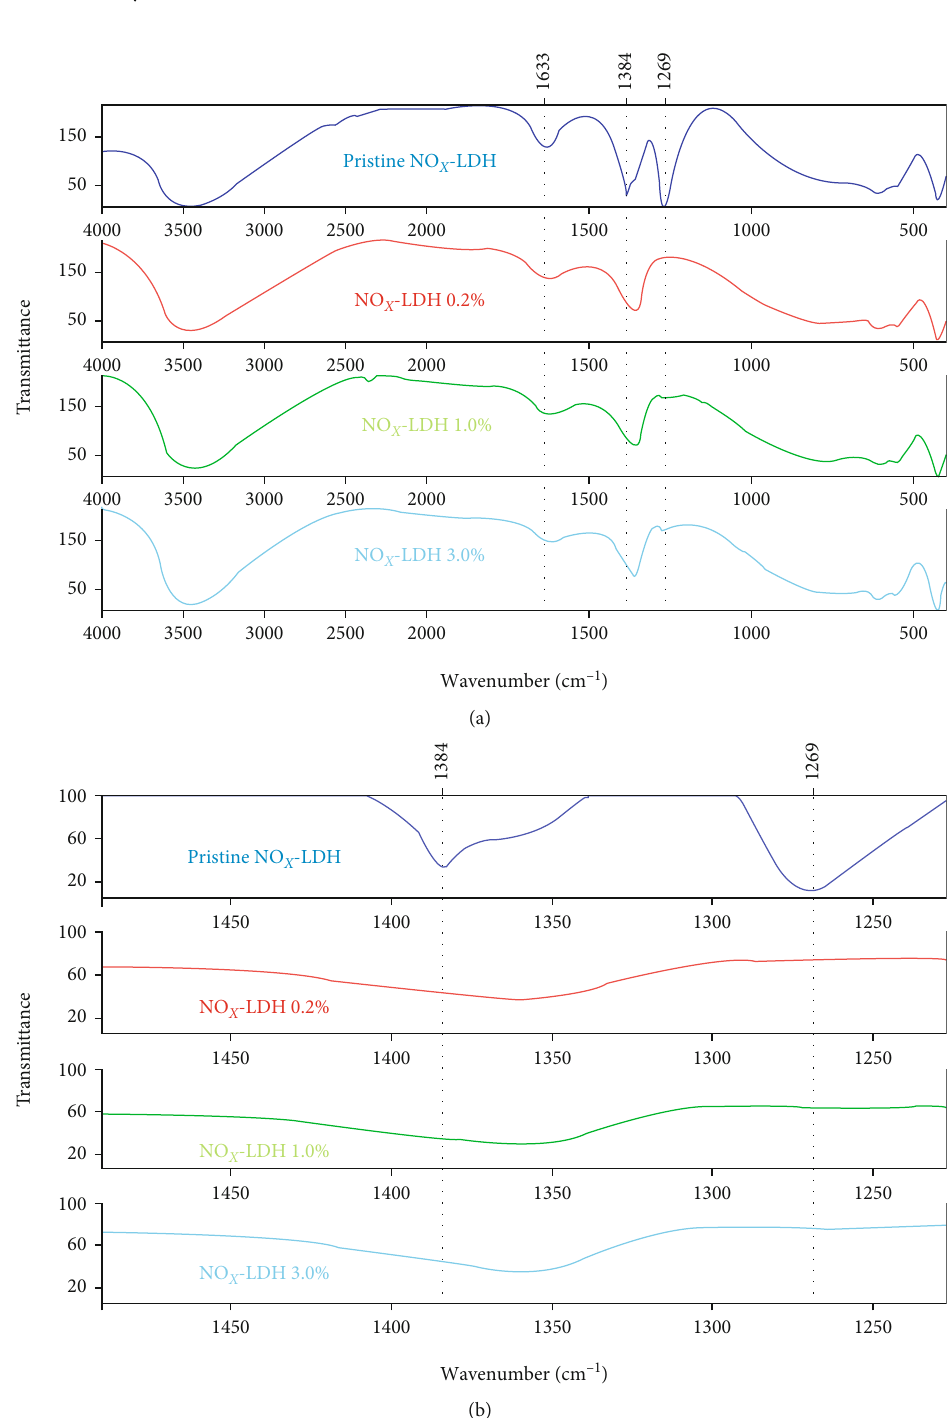
-LDH before and after exposure to 3.5% NaCl (a) spectrum in full and (b) zoom in the x